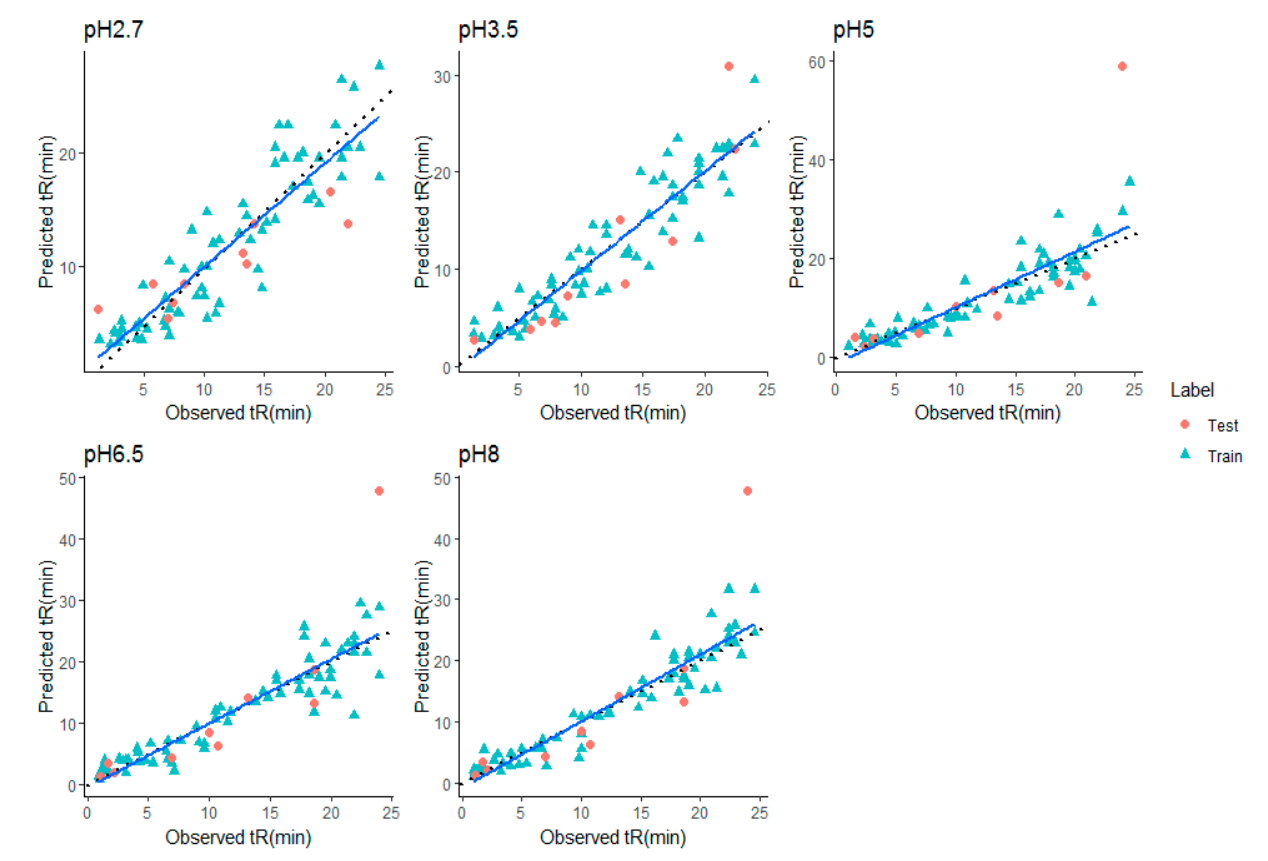
Figure 3. Predicted vs. experimental retention times (in min.) for stacking model at all pHs (Blue line—Fit line, Black dashed line—identity line).